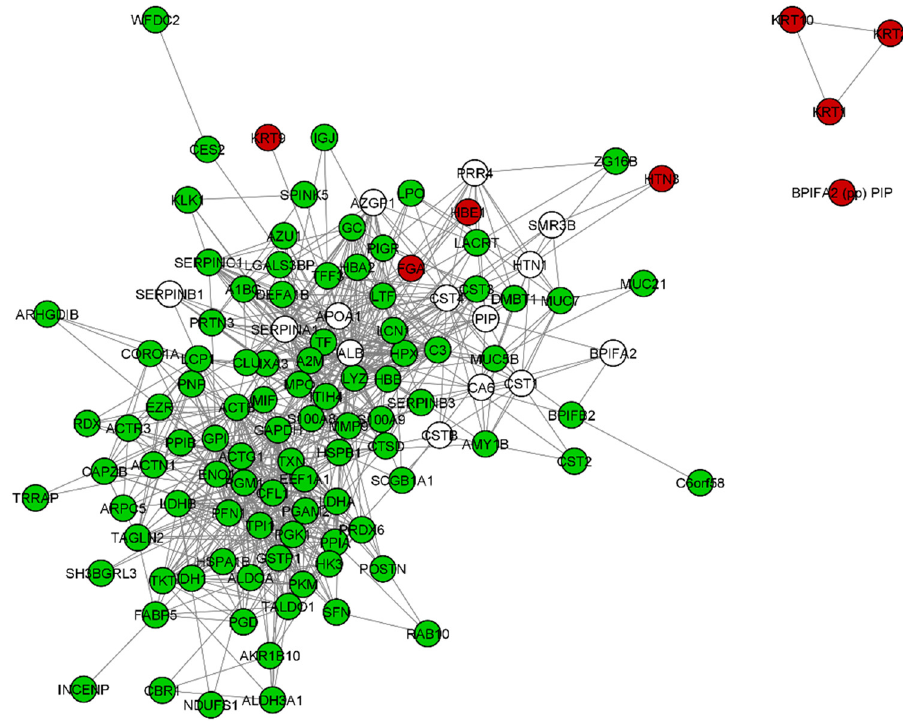
Figure 2: DyNet visualization of assembly gene/protein networks identi fi ed by in - solution digestion strategies: only protocol B ‒ green circles, only protocol G ‒ red circles, and both samples ‒ white